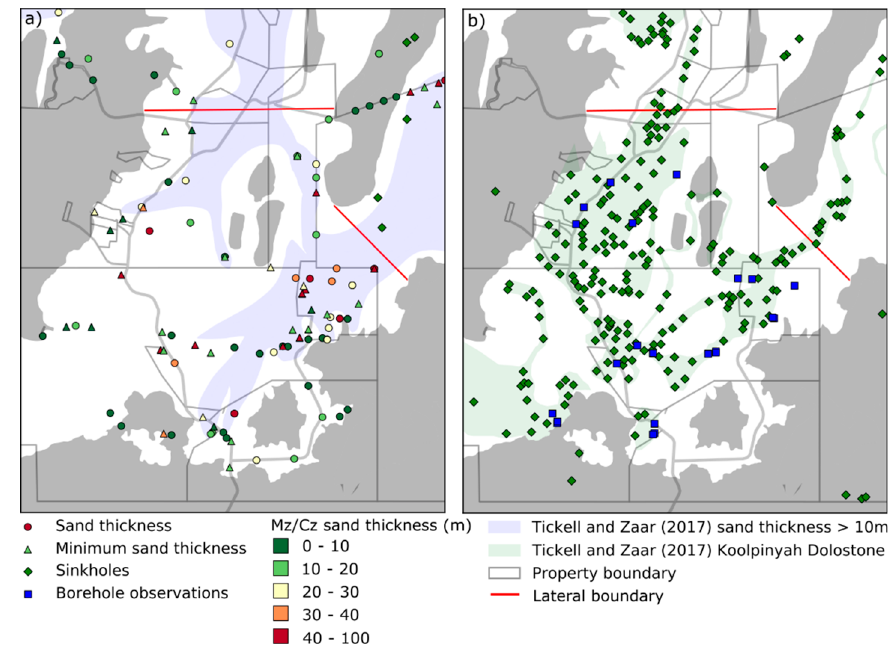
Figure A2. ( a ) The observations of thickness of the Mz / Cz sand in boreholes, where the triangle indicates boreholes where the bottom of the Mz / Cz sand has not been observed and the interpretation is by [50]. ( b ) The location of observed sinkholes and boreholes observations of the Koolpinyah Dolostone with the interpretation of the extent of the Koolpinyah Dolostone by [50].